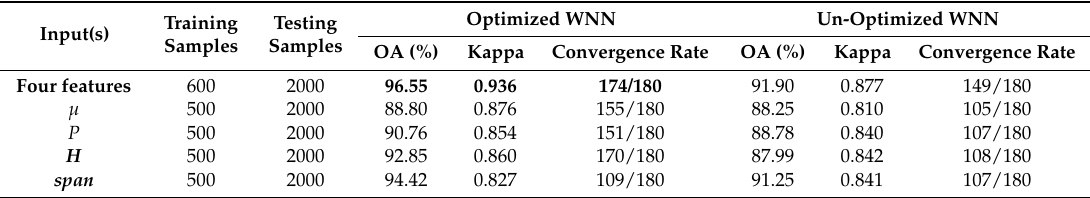
Table 6. The experimental results of Dataset 1.